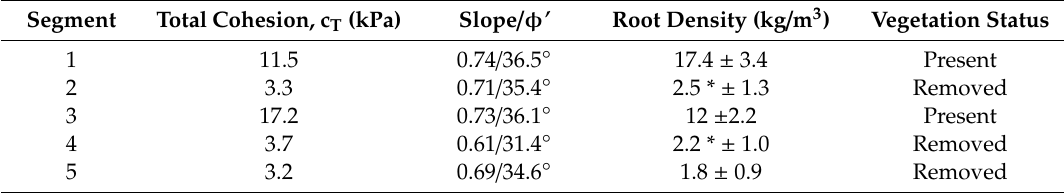
Table 4. Shear strength parameters and root densities obtained for ditch segments 1–5.